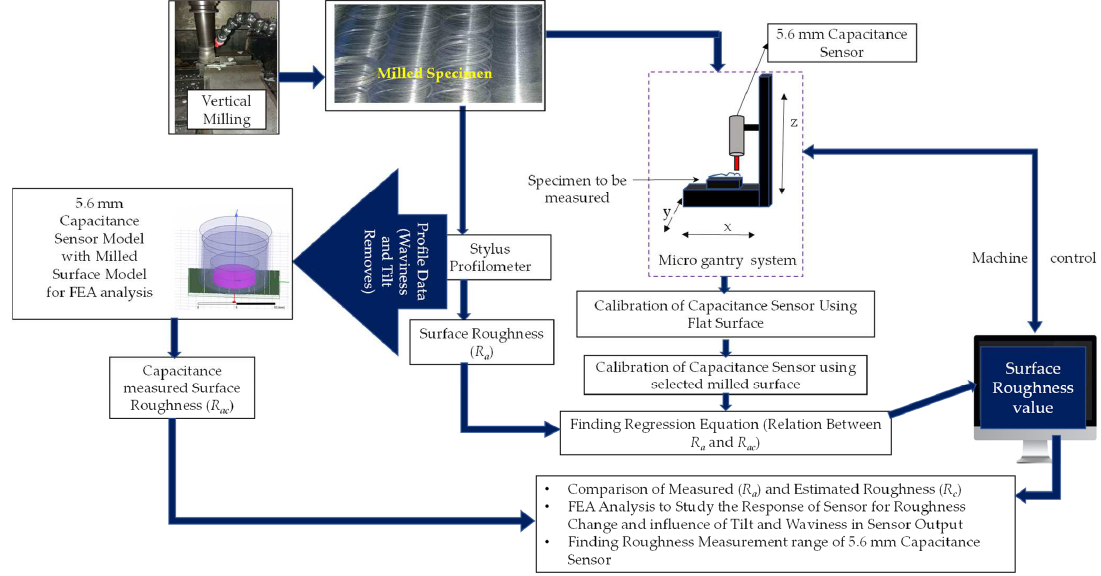
Figure 2. Methodology.